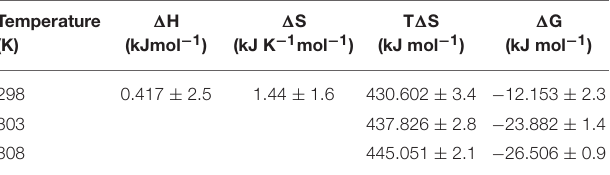
TABLE 2 | Thermodynamic parameters for the binding of doripenem to CTX-M-15 as estimated from fluorescence quenching at different temperatures. Temperature